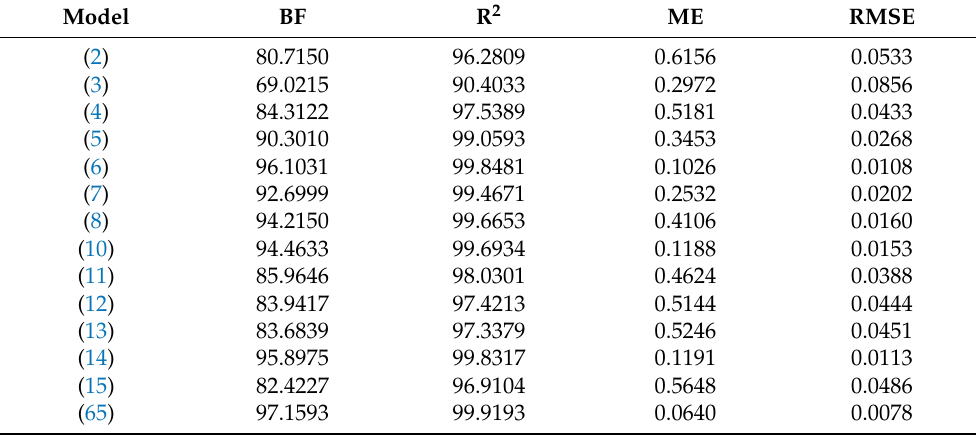
Table 4. OCV Prediction